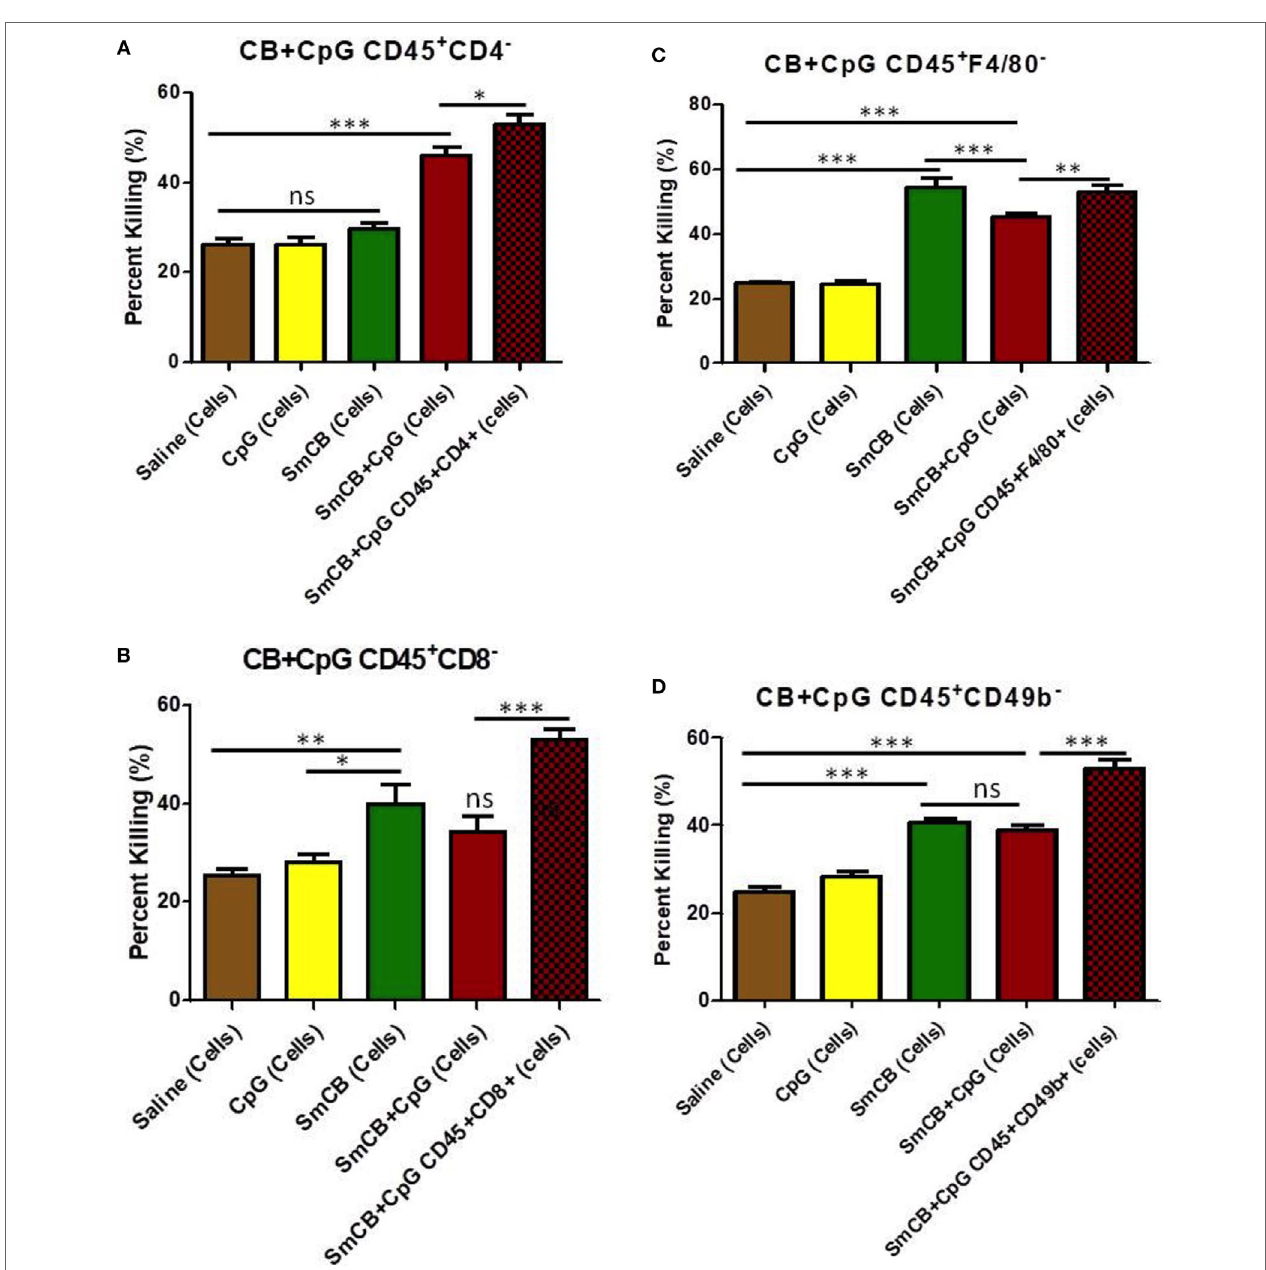
FigUre 4 | Schistosoma mansoni Cathepsin B (Sm-Cathepsin B) alone and Sm-Cathepsin B + CpG: parasite killing after the depletion of different cell populations. Sixty mechanically transformed schistosomula were incubated 24 h at 37°C, 5% CO 2 . Lung cells were collected from the different immunized mouse groups: saline, CpG dinucleotides, Sm-Cathepsin B, and Sm-Cathepsin B + CpG. The different depletions and comparisons were as follows: (a) parasite killing was analyzed for all groups after CD4 cell depletion; saline n = 10, CpG. n = 10, Sm-Cathepsin B n = 10, Sm-Cathepsin B + CpG n = 14. In addition, parasite killing was compared between Sm-Cathepsin B + CpG CD45 + CD4 − and Sm-Cathepsin B + CpG CD45 + CD4 + ( n = 14). (B) Parasite killing was analyzed for all groups after CD8 cell depletion; n = 5 for all groups. In addition, parasite killing was compared between Sm-Cathepsin B + CpG CD45 + CD8 − and Sm-Cathepsin B + CpG CD45 + CD8 + ( n = 14). (c) Parasite killing was analyzed for all groups after F4/80 cell depletion; saline n = 7, CpG n = 7, Sm-Cathepsin B n = 7, Sm-Cathepsin B + CpG n = 11. In addition, parasite killing was compared between Sm-Cathepsin B + CpG CD45 + F4/80 − and Sm-Cathepsin B + CpG CD45 + F4/80 + ( n = 14). (D) Parasite killing was analyzed for all groups after CD49b cell depletion; saline n = 7, CpG n = 7, Sm-Cathepsin B n = 7, Sm-Cathepsin B + CpG n = 11. In addition, parasite killing was compared between Sm-Cathepsin B + CpG CD45 + CD49b − and Sm-Cathepsin B + CpG CD45 + CD49b + ( n = 14). ns: not significant, p > 0.05, * p ≤ 0.05, ** p ≤ 0.01, *** p ≤ 0.001. The brown columns represent data from the saline group post depletion. The yellow columns represent data from the CpG adjuvant group post depletion. The green columns represent data from the Sm-Cathepsin B group post depletion. The red columns represent data from the Sm-Cathepsin B + CpG group post depletion. The single red checkered columns represent the undepleted Sm-CathepsinB + CpG sample for the immune serum + cells culture